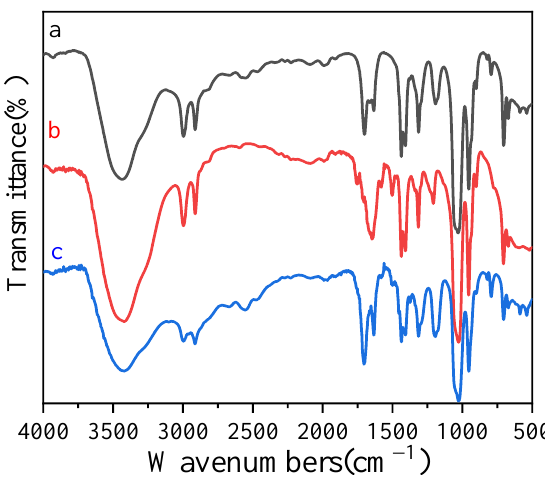
Figure 5. FT − IR spectra of (a) MAA, (b) CAP, and (c) CAP − MAA. 1 H NMR has been used to further examine the hydrogen-bonding forces between template molecules and functional monomers [34]. Under the same assay conditions, two absorption peaks appeared in the 1 H-NMR spectrum of CAP at a chemical shift of 11.69, while a sharp singlet was exhibited at 10.51, as shown in Figure 6a. These peaks mainly arose from the two active hydrogens that were differently affected by the surrounding structure. The sharp absorption peak of the secondary hydrogen in CAP was observed at the chemical shifts of 5.05 and 5.44. The active hydrogen at this position is subjected to an isolated lone pair and base p-electron on N conjugation, so that the C-N bond exhibits a partial double-bond character, resulting in a sharp single peak. After adding MAA, two active hydrogens on the hydroxyl group in CAP ( δ = 1 1.69, 10.51) and MAA active hydrogen ( δ = 1 2.38) both occurred at a chemical shift of 12.18, as shown in Figure 6c. This is likely because the hydrogen bonds are chemically identical. The secondary hydrogen ( δ = 5.04) in CAP exhibits two broad adsorption peaks, while the hydroxyl group forms a hydrogen bond with the carboxyl group in MAA. 12